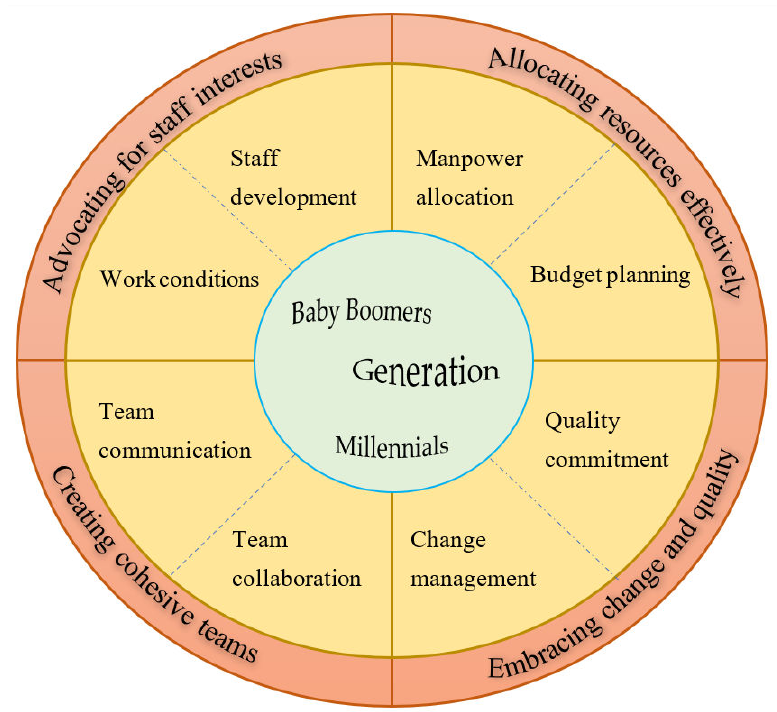
Figure 2. Competencies required of first-line nurse